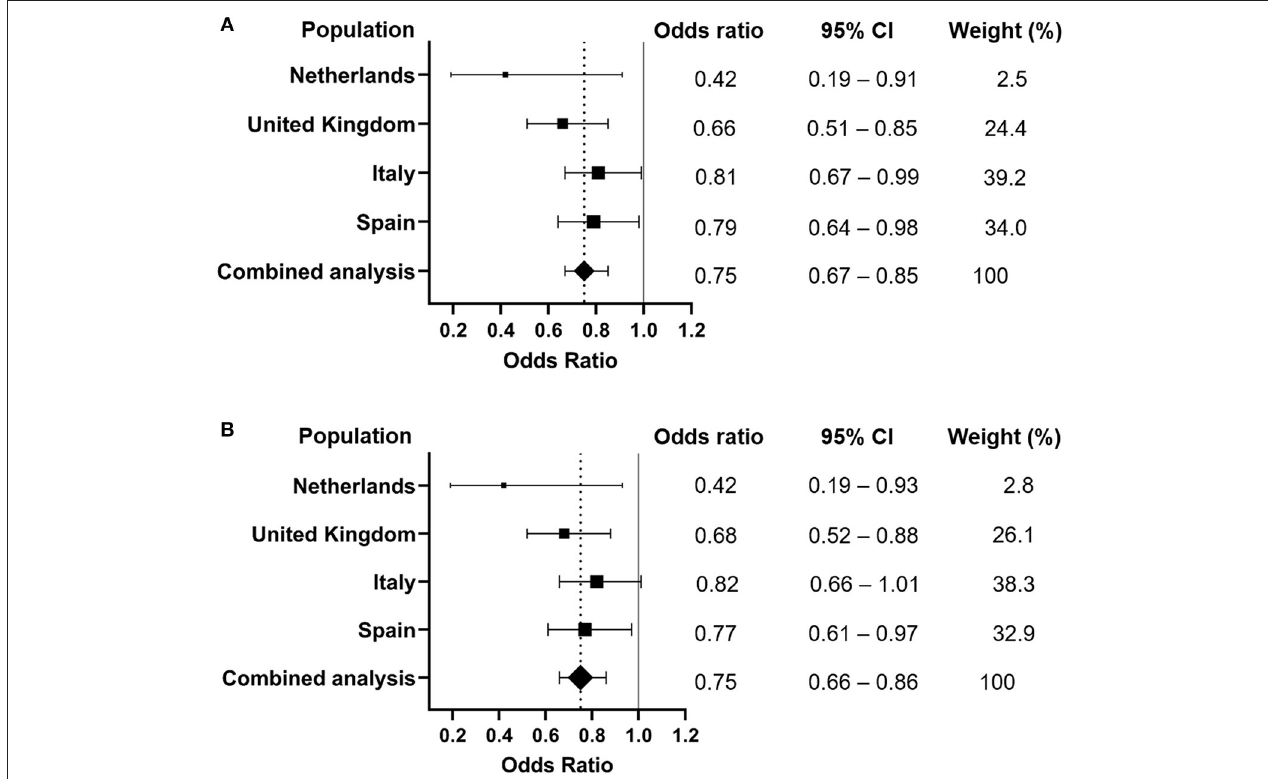
FIGURE 1 | Forest plots of meta-analyses of the association of MUC5B rs35705950 with severe COVID-19 in subjects of European ancestry. Dotted line represents the odds ratio from the combined analysis. (A) Meta-analysis of allele contrast (T vs. G; P combined analysis = 6.63 e-06). (B) Meta-analysis of the dominant T-allele carriage model (GT + TT vs. GG; P combined analysis = 2.05e-05). CI, confidence